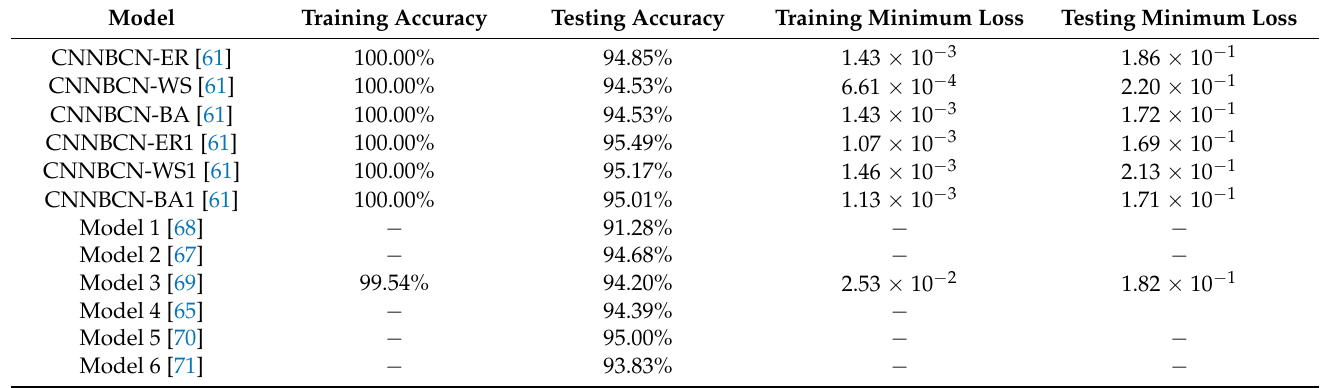
Table 9. Performance comparison in terms of accuracy and loss.